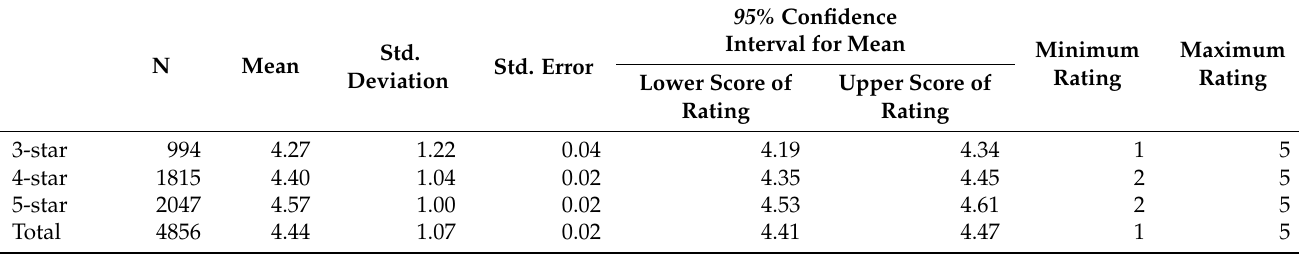
Table 3. Descriptive Analysis